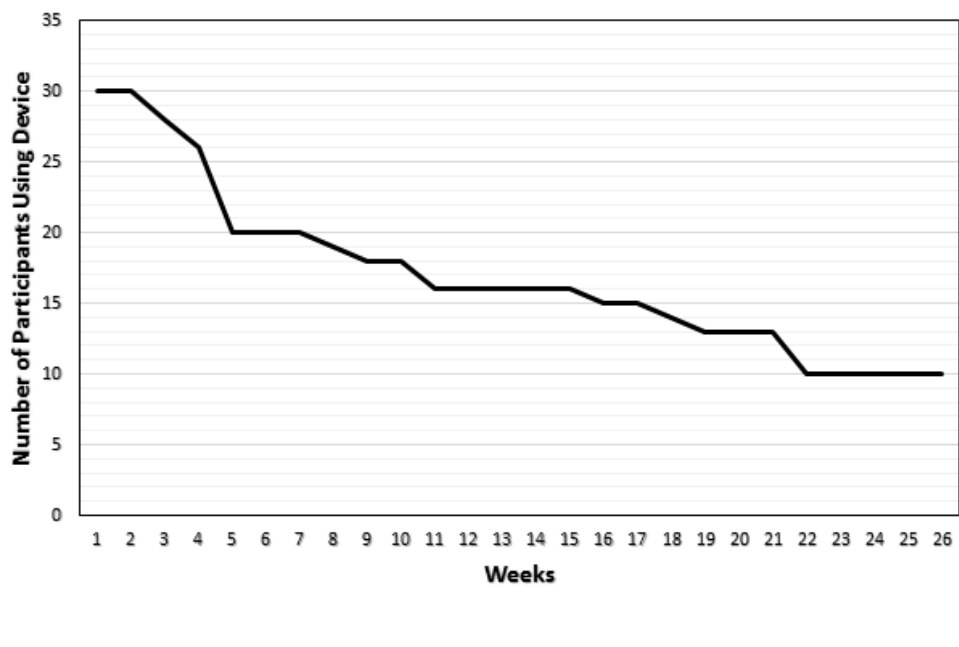
Figure 2. Number of participants, by week, who continued to use their wearable device for tracking physical activity during